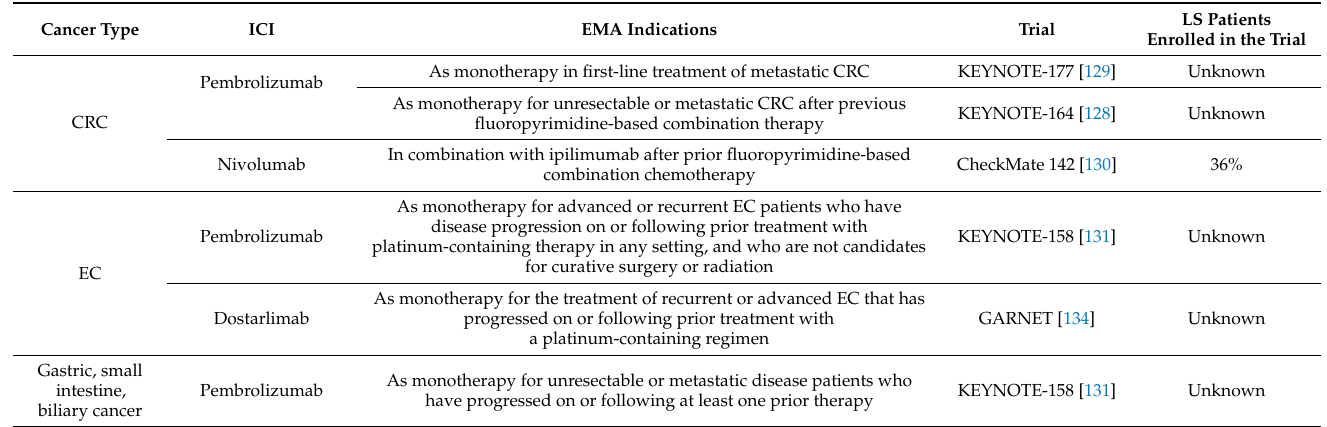
Table 3. EMA-approved immune checkpoint inhibitors in dMMR/MSI-H malignancies (ICI: immune checkpoint inhibitor; CRC: colorectal cancer; EC: endometrial cancer; LS: Lynch